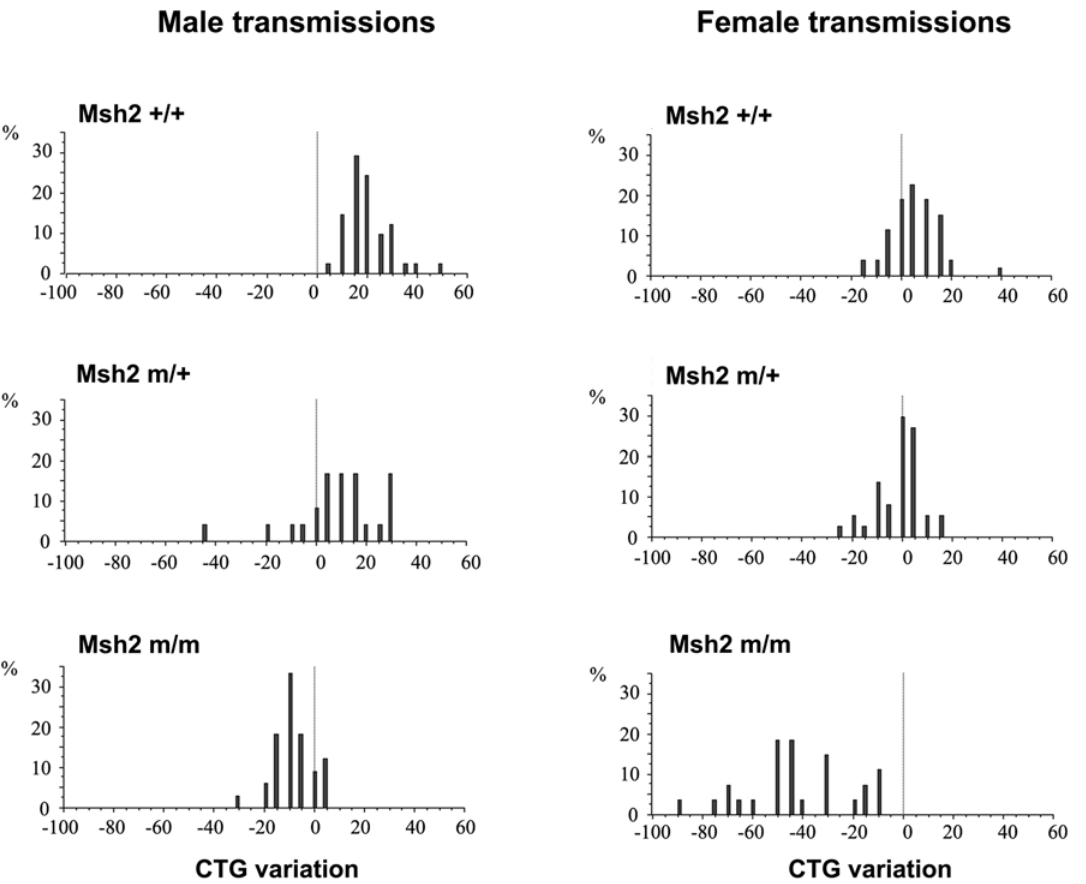
Figure 1. Intergenerational instability of CTG repeat in Msh2 G674A mutant and wild-type mice. The x-axis shows CTG repeat length changes and the y-axis the percentage corresponding to each size changes for all transmissions analysed. Genotypes of parent and offspring are indicated on the left of each graph. For male transmissions, the transmitting progenitors were aged 14–52 weeks and carried an expanded trinucleotide sequence varying 395 to 563 CTG repeats. For female transmissions, the transmitting progenitors were aged 10–40.5 weeks and carried an expanded trinucleotide sequence varying from 401 to 647 CTG repeats.